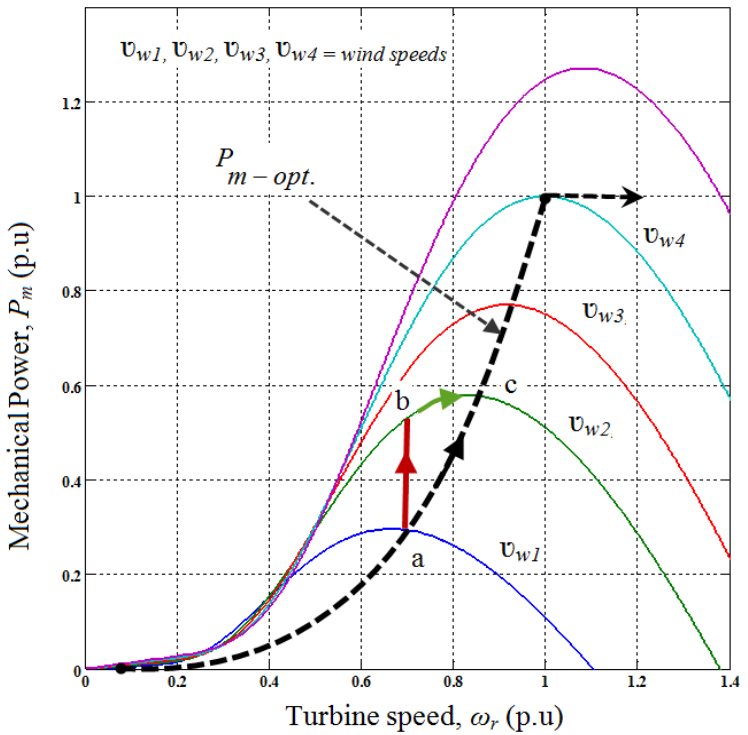
Figure 3. The relation among mechanical powers generated and rotor speeds for different wind